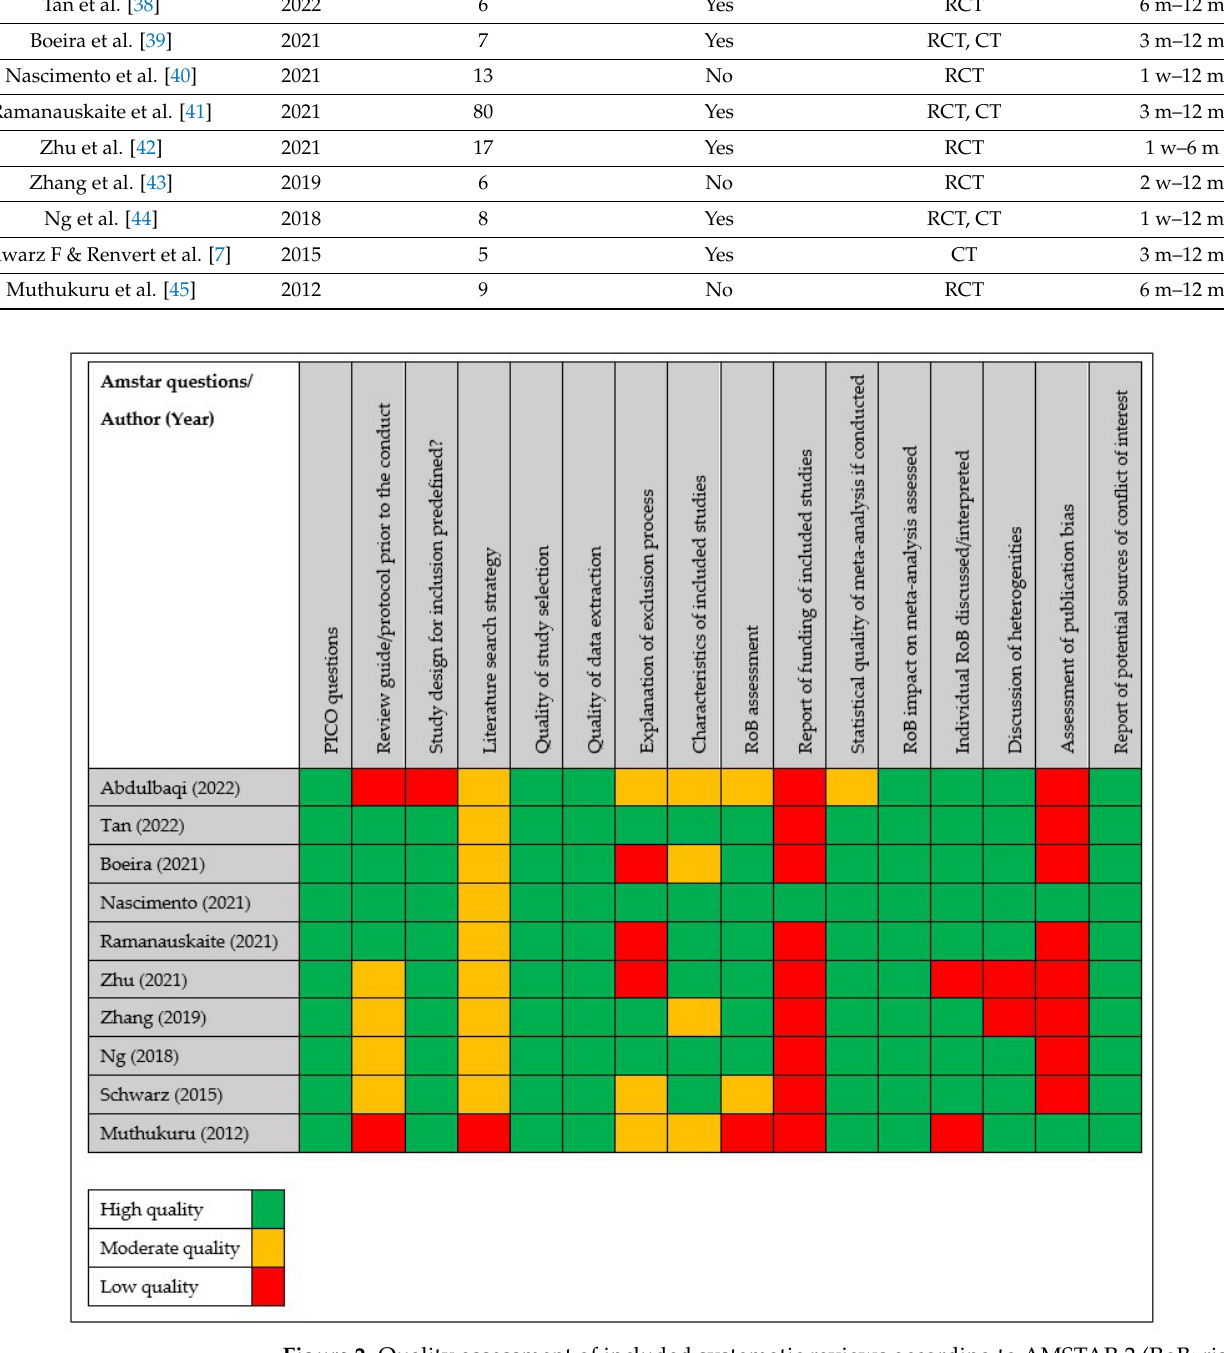
Figure 2. Quality assessment of included systematic reviews according to AMSTAR 2 (RoB: risk of bias)